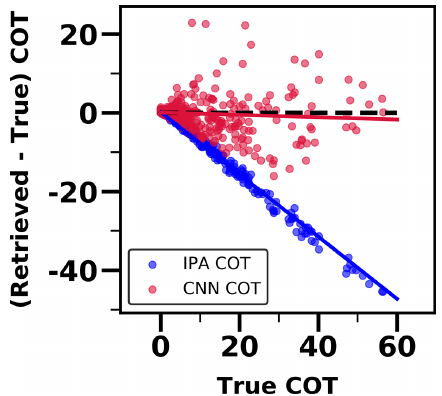
Figure 2. A scatter plot comparing the COT retrieved by the IPA method (blue scatter) and the CNN (red scatter) as a function of the true COT. The dashed black line depicts the ideal retrieval having a slope of 0. The solid blue and red lines are linear regression lines fitted to the IPA and CNN retrievals,